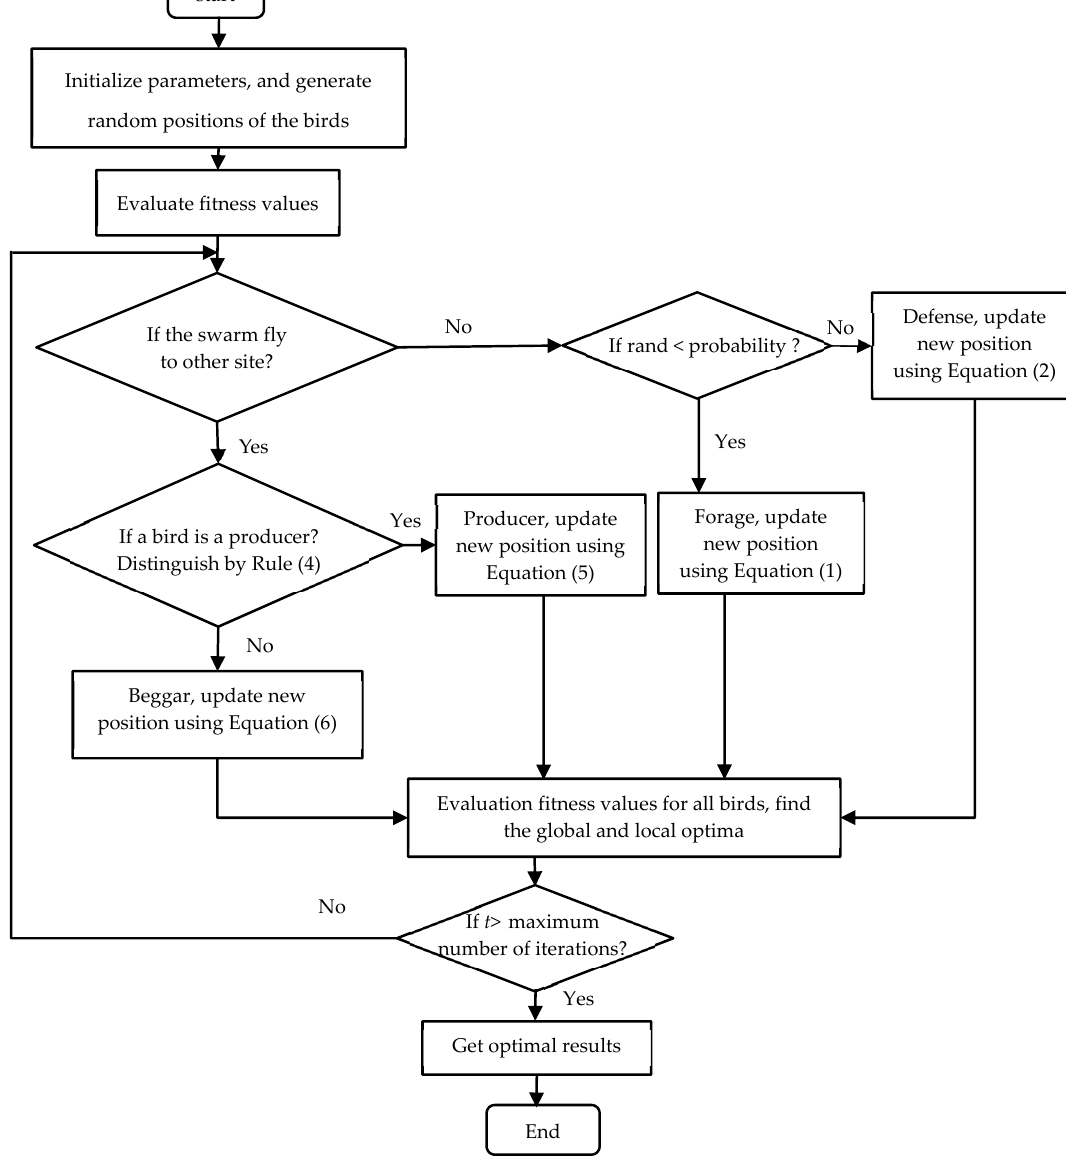
Figure 2. Workflow of bird swarm algorithm (BSA).